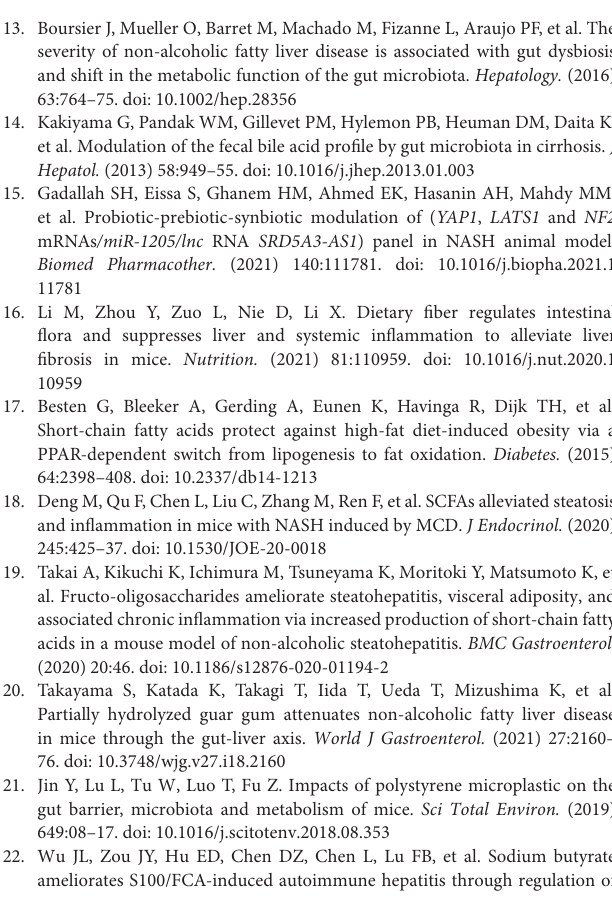
Supplementary Table 1 | Primers used in real-time qPCR. Supplementary Table 2 | Design of GPR43 siRNA targeting sequences. Supplementary Table 3 | Design of PPAR γ siRNA targeting sequences. Supplementary Table 4 | Comparsion of level of protein phosphorylation among